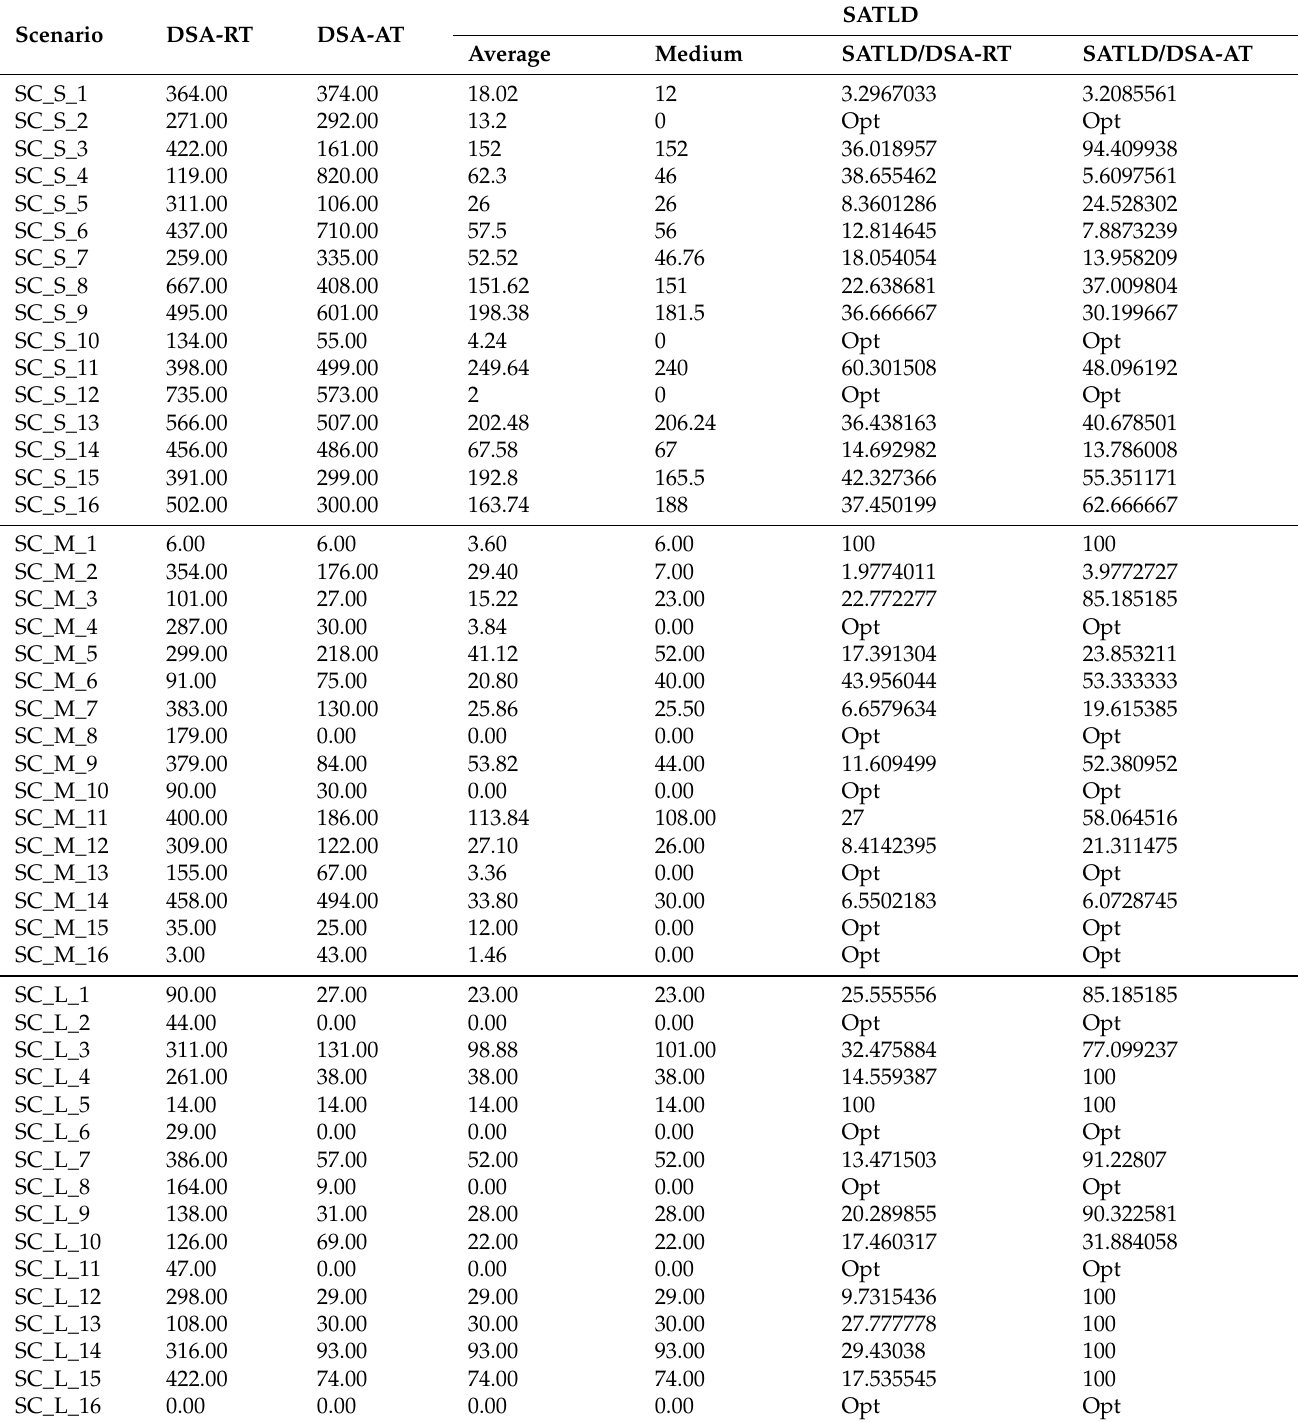
Table 4. Experiment results for waiting